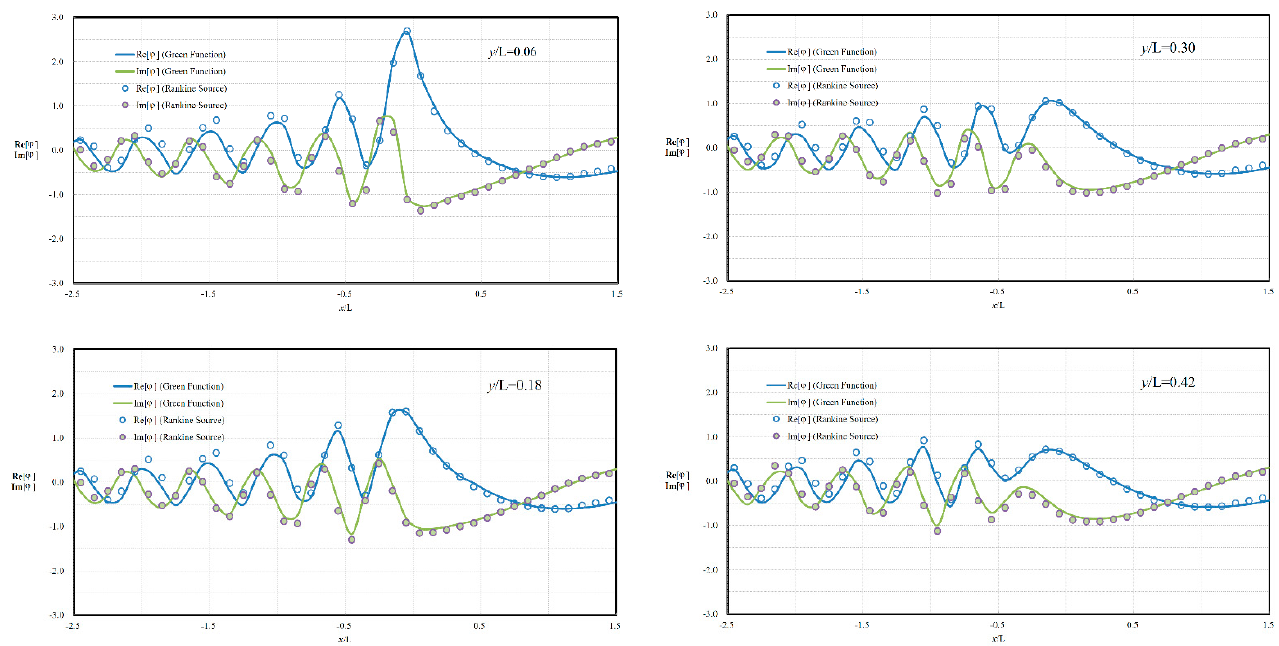
Figure 12. Comparison of induced velocity potential along lines.